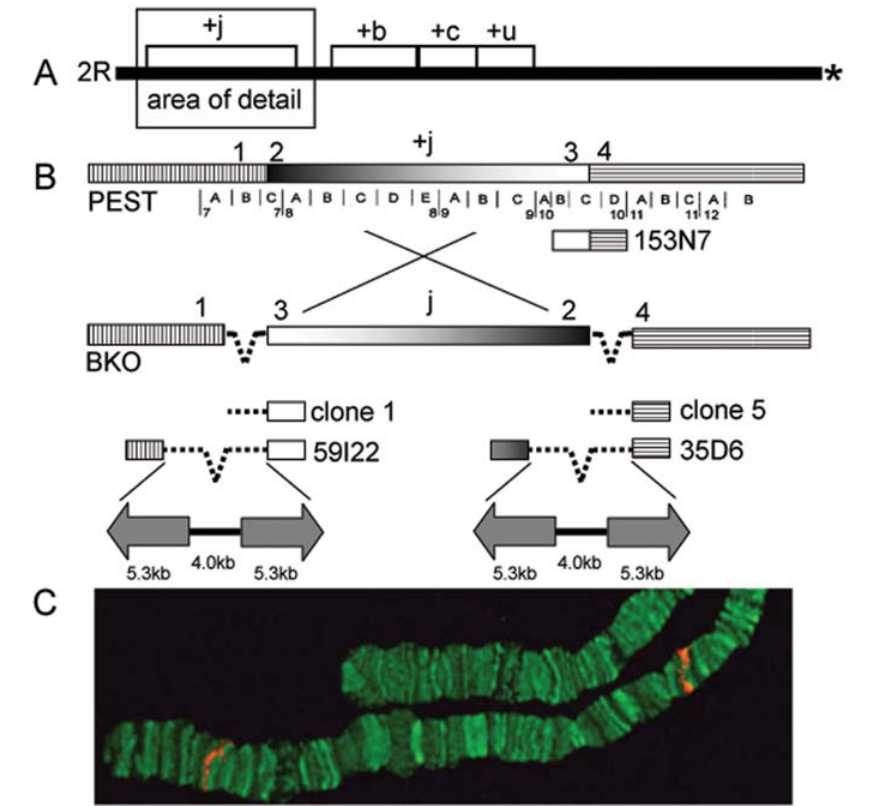
Figure 2. Cloning strategy for the 2Rjinversion breakpoints. (A) Relative position of four paracentric inversions ( j , b , c , u ) on chromosome 2 R in An. gambiae . Asterisk represents the centromere. (B) Schematic of alternative arrangements of 2 Rj in PEST ( + j ) and BKO ( j ) strains (not to scale). The cytogenetic map represented beneath the PEST chromosome shows the breakpoints positioned in subdivision 7C and 10C. Numbers above the chromosomes are used in the text to refer to corresponding regions adjacent to the breakpoints, represented as identically hatched or shaded regions in alternative arrangements. Dashed line indicates repetitive DNA insertion. Shown beneath the PEST chromosome is a representation of BAC 153N7 that spans the proximal breakpoint. Below the BKO chromosome are plasmid (1, 5) and fosmid (59I22, 35D6) clones corresponding to the breakpoints of the j arrangement. Structure of the repetitive DNA in 59I22 and 35D6 is represented below as arrows (inverted repeats) separated by a solid line (central spacer) of indicated lengths in kb. (C) FISH performed on the chromosomes of the BKO strain (2 Rj ) with BAC 153N7. Signals in red indicate the distal and the proximal breakpoints of the j inversion.